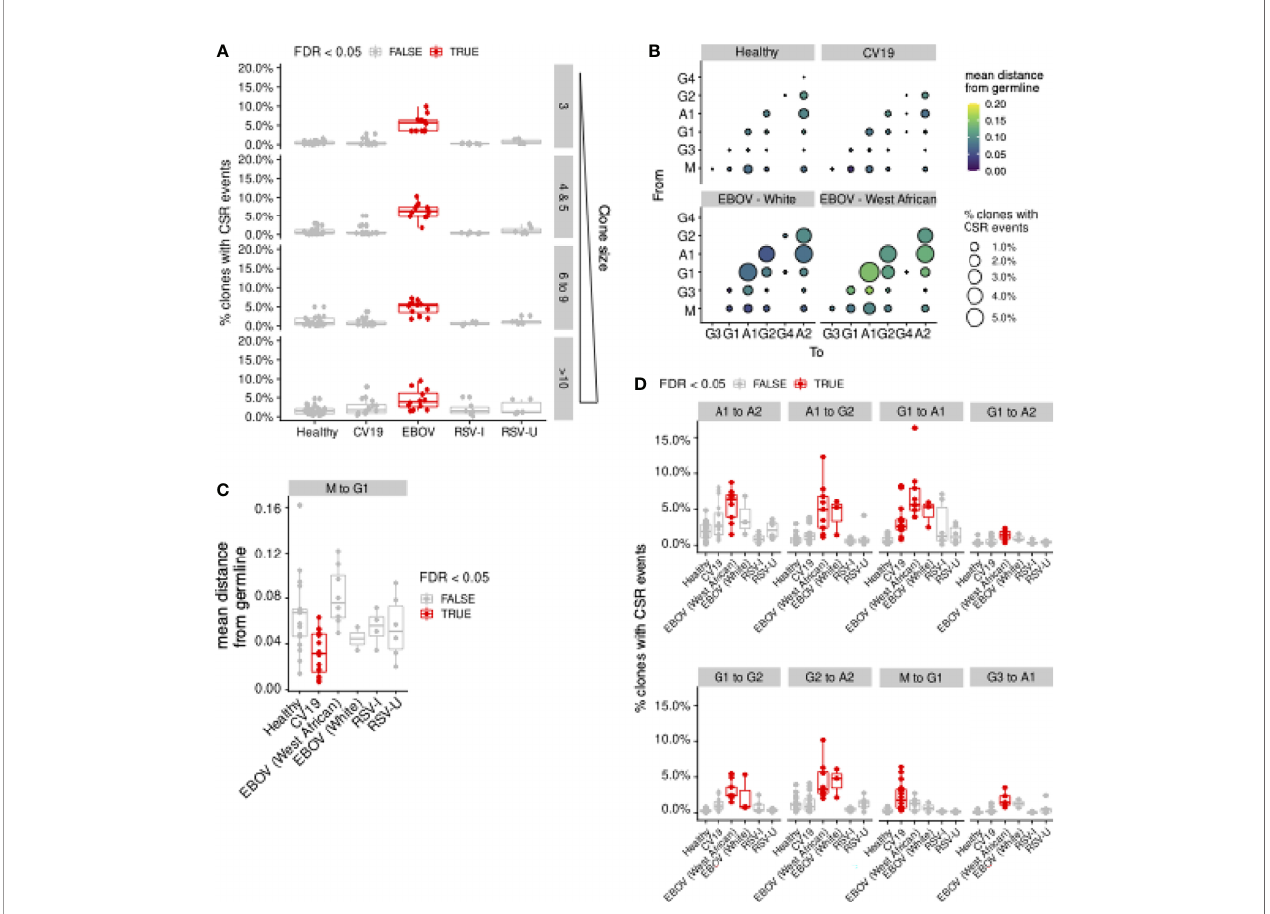
FIGURE 6 | Evidence of Class-switch recombination is increased in EBOV and in large CV19 expansions. Repertoires from each donor were sampled to uniform depth (12,000, approximately the median sequence counts over all donors across all sample types). (A) Lineage clones (see Figure 5) were assessed for prevalence of CSR events in terms of the proportion of clones and plotted by clone size and split by condition. (B) Bubble plot depicting the frequency and distance-from-germline of CSR events, separated by the CSR start ( ‘ From ’ , vertical axis) and end ( ‘ To ’ , horizontal axis) isotypes. Quanti fi cation was performed separately for different sample types. Bubble sizes are proportional to the frequency of CSR and colour is scaled by distance from germline at which CSR occurs, as estimated from the reconstructed lineage trees. (C) Statistical comparison of the median distance from germline at which CSR events occurred across sample types. Each donor was considered separately for every switch possibility. (D) Comparison of CSR frequency (percentage of clones with evidence of CSR) for each condition was also assessed for each donor (median, D ). Statistical signi fi cance was evaluated using one-way ANOVA and Dunnett post-hoc comparison against Healthy with Benjamini-Hochberg-corrected false discovery rate (FDR) < 0.05 highlighted in red (C, D) . For (D) , Supplementary Figure S9 contain analogous plots for all CSR combinations with signi fi cant (FDR < 0.05) differences compared against